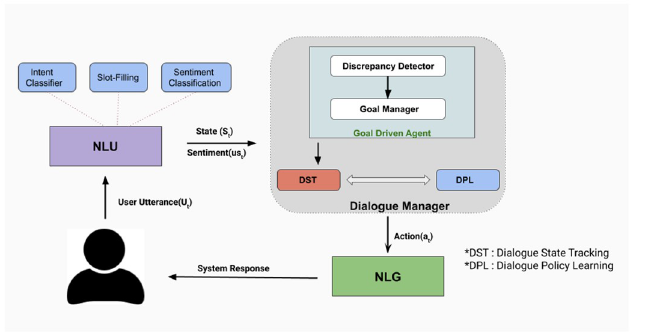
Fig 4. System architecture of the proposed